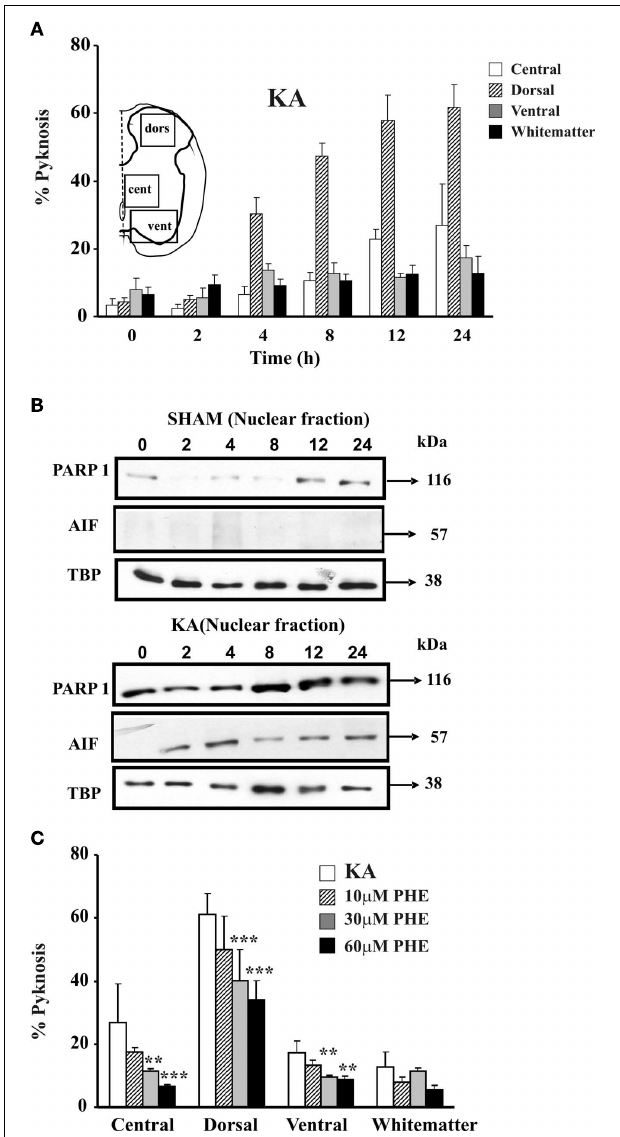
FIGURE 3 | Kainate mediated excitotoxicity evokes PARP-1 dependent cell death (Parthanatos) in spinal cord in vitro . (A) Histograms plot percent occurrence of pyknosis detected at various time points after washout (0h) of kainate (1mM; 1h application; KA). Inset shows the schematic representation of the areas sampled for the cell count based on DAPI staining. For each time point n = 3 spinal cords. (B) Example of Western immunoblotting of spinal cord samples obtained from sham (upper panels) or kainate treated (lower panels) preparations, and tested with PARP-1 or AIF specific antibody. In kainate treated spinal cords there is increased PARP-1 immunoreactivity, with early appearance immediately after kainate treatment (0h) and rising up to 24h after. AIF immunoreactivity appears in the nuclear fraction 2h after kainate treatment. Nuclear loading assessed withTBP. (C) Histograms plot percent of pyknosis occurrence detected in different spinal cord regions 24h after kainate treatment alone or followed by treatment with PARP-1 inhibitor PHE (three different concentrations). PHE significantly reduces (** P < 0.01; *** P < 0.001) the number of pyknotic cells in a dose-dependent manner in all four spinal cord regions. Pyknosis is normalized with respect to the total number of DAPI sensitive cells. For each time point n = 3 spinal